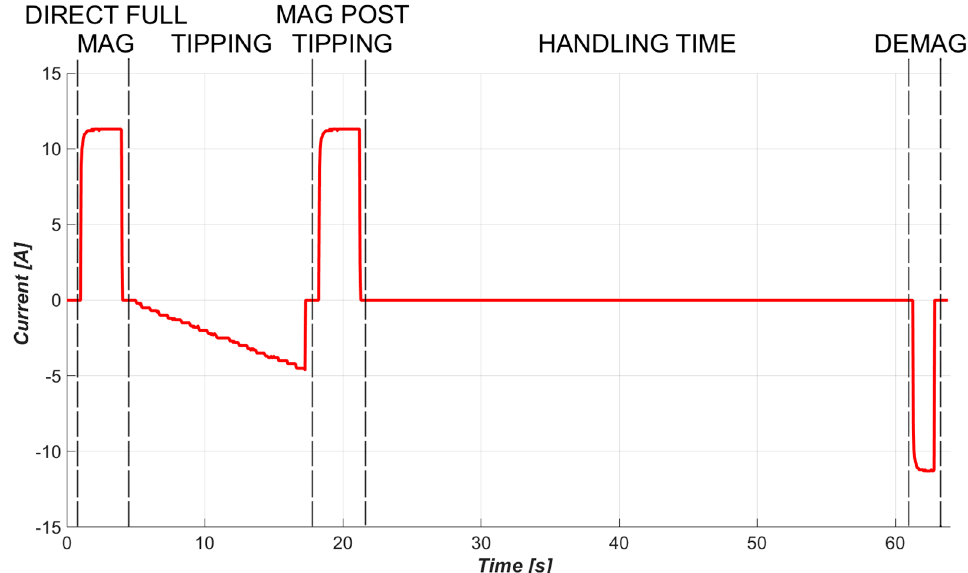
Figure 12. The Case 3 current trend for a complete cycle of the EP system, which starts with the direct full mag phase.